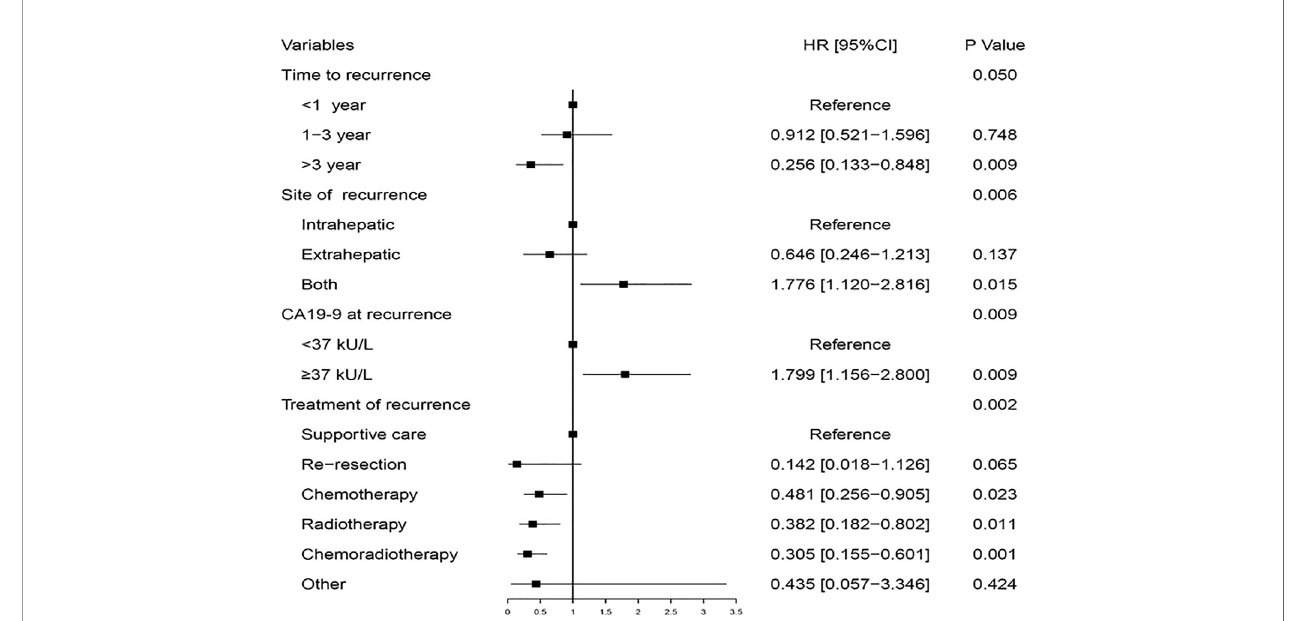
FIGURE 2 | Multivariable analysis of the hazard ratio of post-recurrence survival in the training cohort.